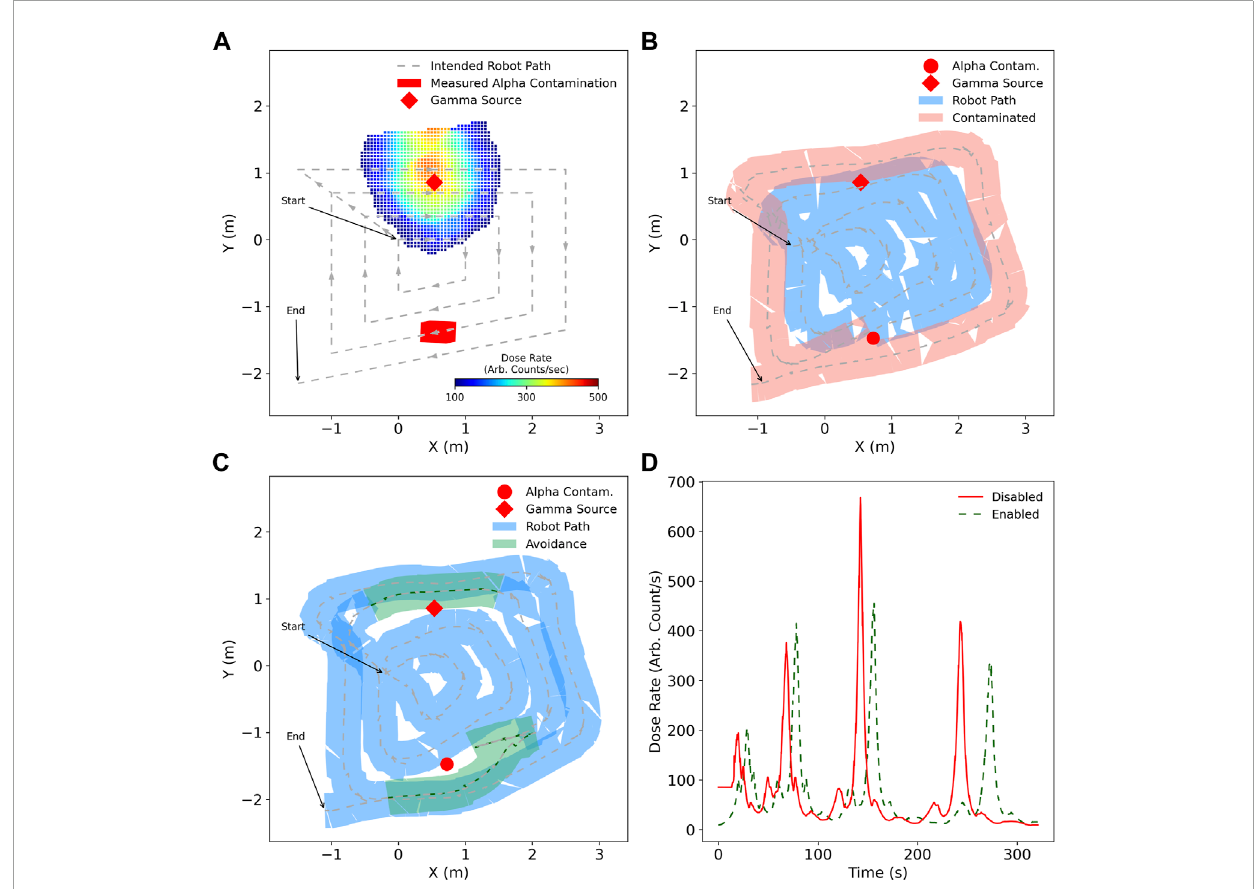
FIGURE 9 Survey of an environment utilising a four loop coverage path, with alpha and gamma radiation sources present. (A) the intended coverage path, with the measured radiation intensity by the end of the survey with avoidance enabled for alpha and gamma, (B) path taken by robot in blue when not aware of ionising radiation risks, with possible spread of mobile alpha contamination as a consequence, (C) robot path with broader alterations to the coverage path in green as a result of radiation awareness, (D) dose rate measured by the robot during the